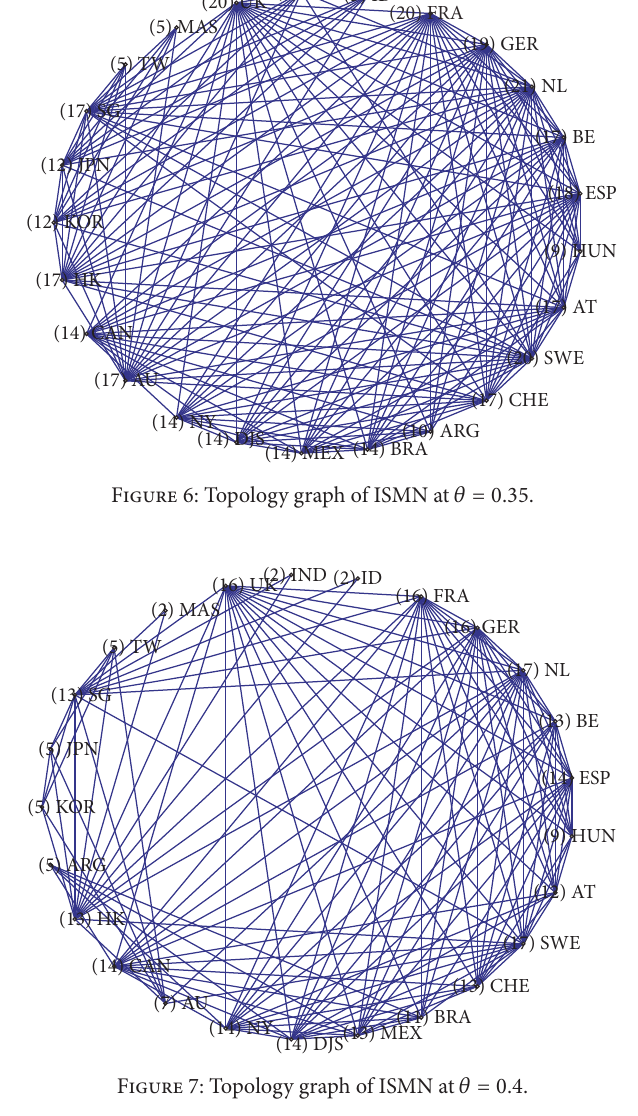
selective removal is 0.8408, which is similar to the value under stochastic removal with 𝑓 = 0.75